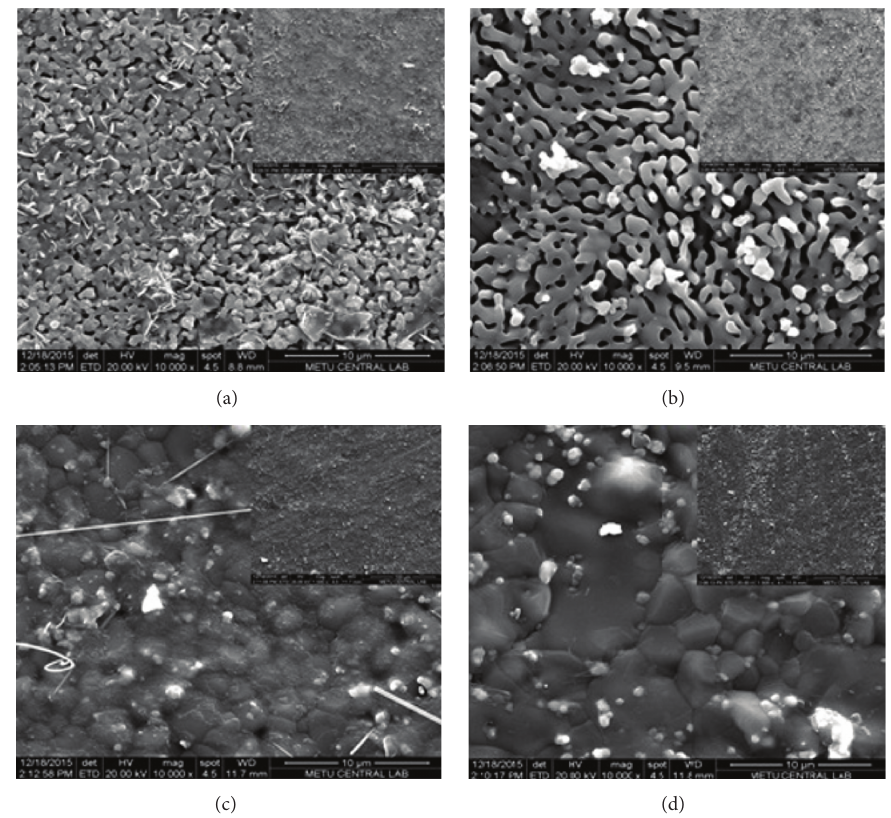
Figure 7: Microstructures of 5BHA composites sintered at (a) 1000 ∘ C, (b) 1100 ∘ C, (c) 1200 ∘ C, and (d) 1300 ∘ C at low ( × 1000, insets) and high ( × 10000, main images)